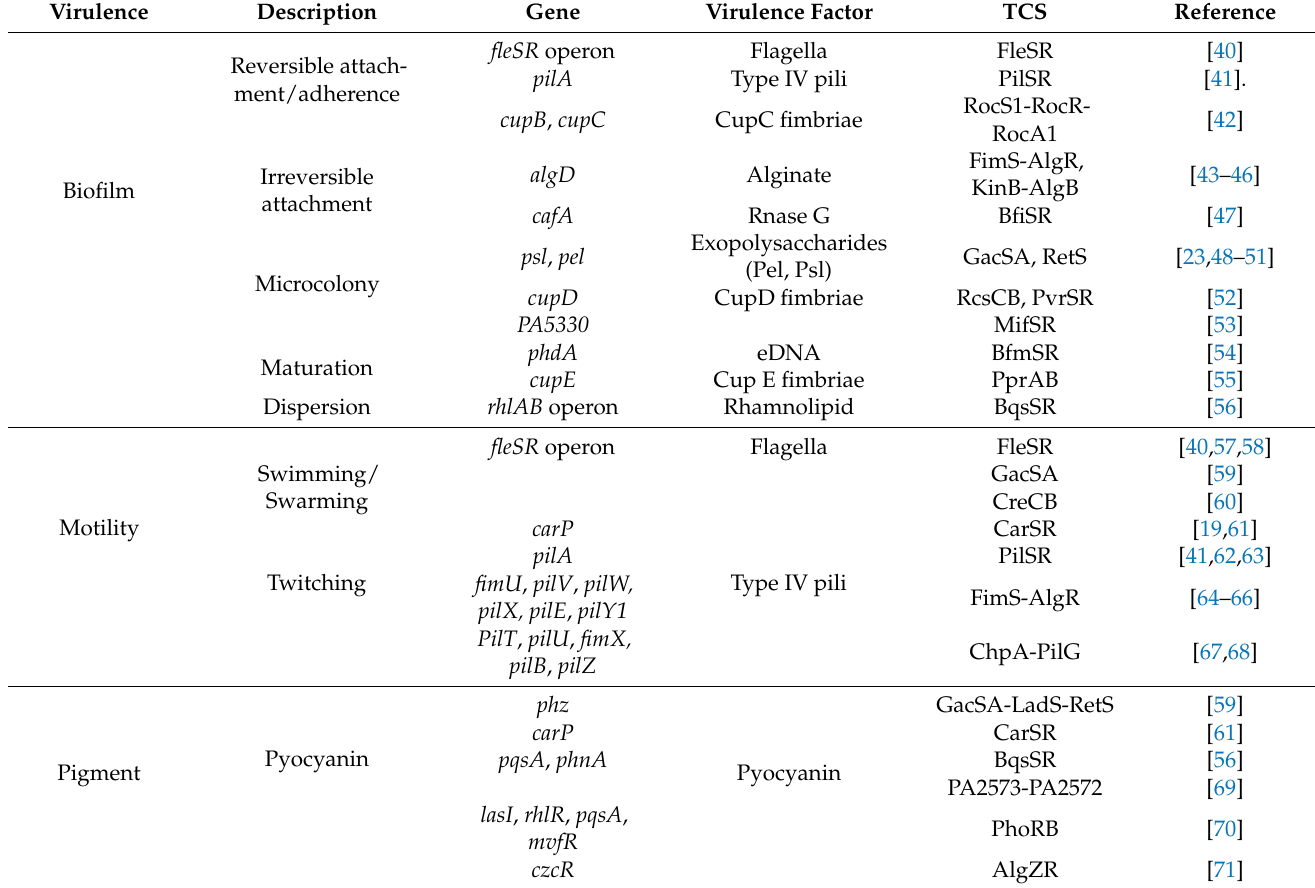
Table 2. List of TCSs that contribute to virulence in P. aeruginosa